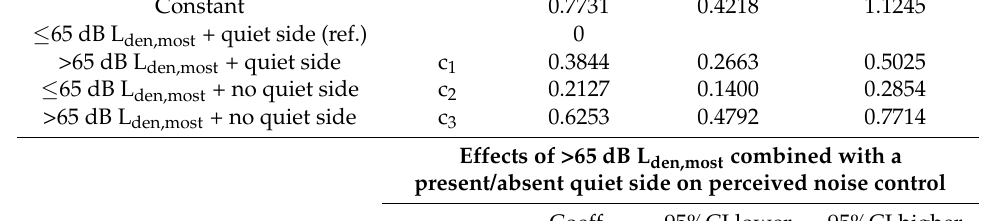
Table 8. Joint associations of exposure to road traffic noise (>65 dB L den,most ) and present/absent quiet side (rooms located at street side) with perceived noise control and noise annoyance 1 . Total Effects of >65 dB L den,most Combined with a N = 1812 Present/Absent Quiet Side on Noise Annoyance Coeff. 95%CI lower 95%CI higher 0.7731 0.4218